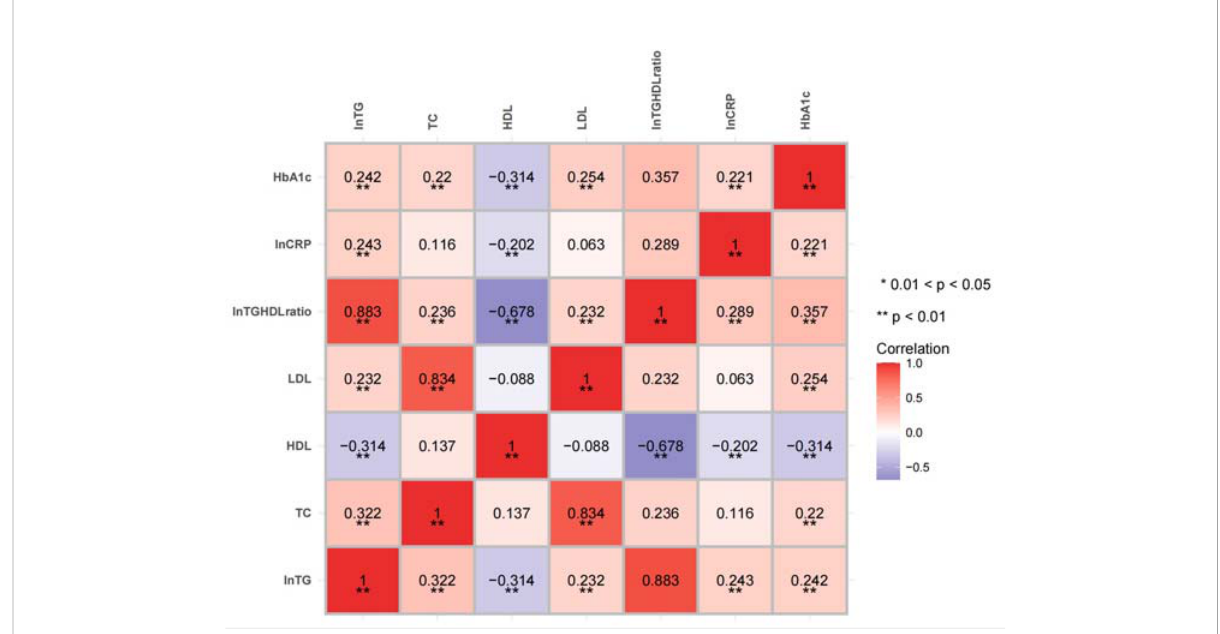
FIGURE 1 Heatmap of the correlation of glycolipid metabolism and in fl ammation marker. The correlation between HbA1C, lipid pro fi les, and the high- sensitivity C-reactive protein (hsCRP) levels adjusted for age and sex. The non-normally distributed traits such as hsCRP, triglyceride (TG), and the TG/HDL (high-density lipoprotein) ratio were natural logarithmic transformed. Red and blue indicate a positive and a negative association, respectively. Color intensity represents the strength of the correlation. *0.01 < p < 0.05; ** p < 0.01.